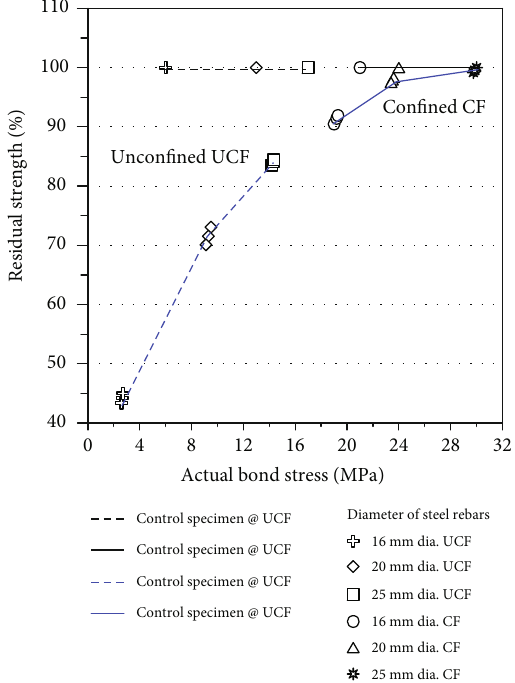
Figure 15: Variation of bond